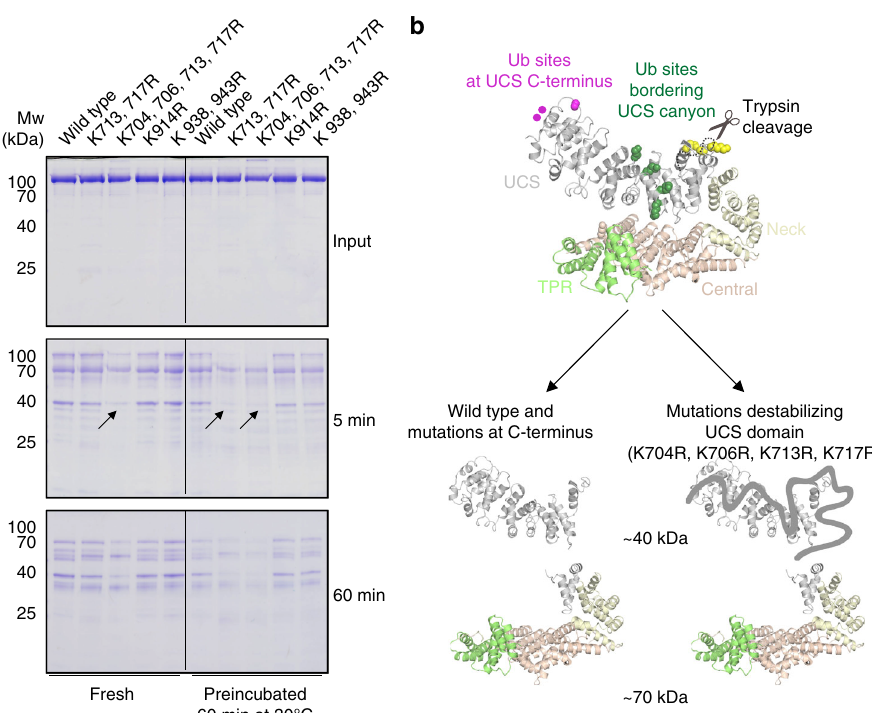
Fig. 6 KR canyon mutations destabilize the UCS domain. a To visualize unfolded portions of the UNC-45 protein, limited proteolysis was carried out with trypsin. SDS-PAGE gels show trypsin digests of UNC-45 wild-type and mutant proteins pre-incubated for 60 min at 4 or 30 °C. Arrows highlight the disappearance of the 40 kDa fragment. b Degradation of the 40 kDa portion of UNC-45 illustrates the destabilizing effect of the UNC-45 KR canyon mutations on the C-terminal of the UCS (Fig. 4e). These fi ndings suggest that UFD-2 targets the UCS domain of UNC-45 in a topologically speci fi c manner.